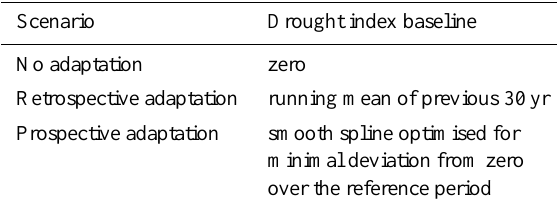
Table 3. Adaptation